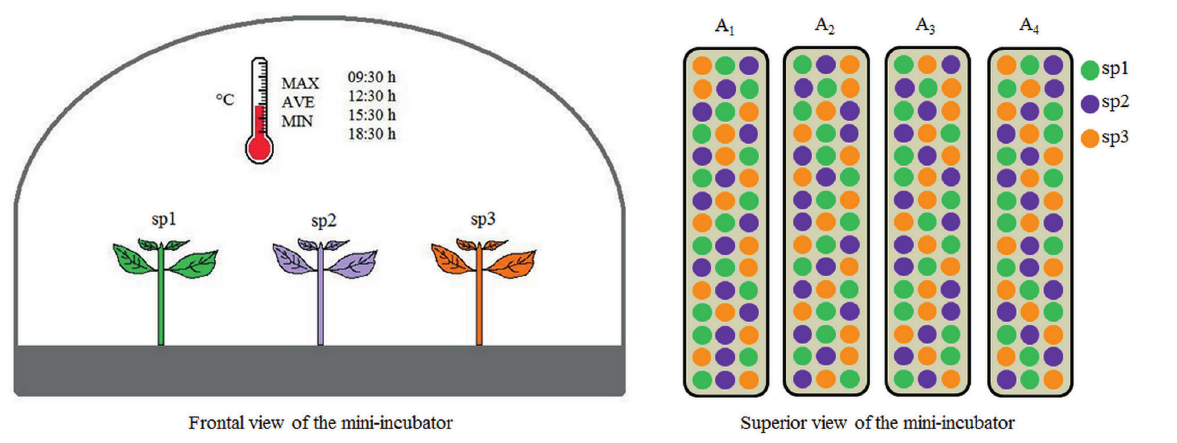
Figure 2 - Random arrangement of microcuttings inside the mini-incubator and allocation in the rooting environment (frontal and superior view). The maximum (MAX), average (AVE) and minimum (MIN) air temperatures inside the mini-incubator were determined four times per day. sp1 = microcutting of Corymbia citriodora , sp2 = microcutting of Eucalyptus urophylla , sp3 = microcutting of E . benthamii . A greenhouse with ventilation and no fogging; A greenhouse with no ventilation but with fogging. MAX